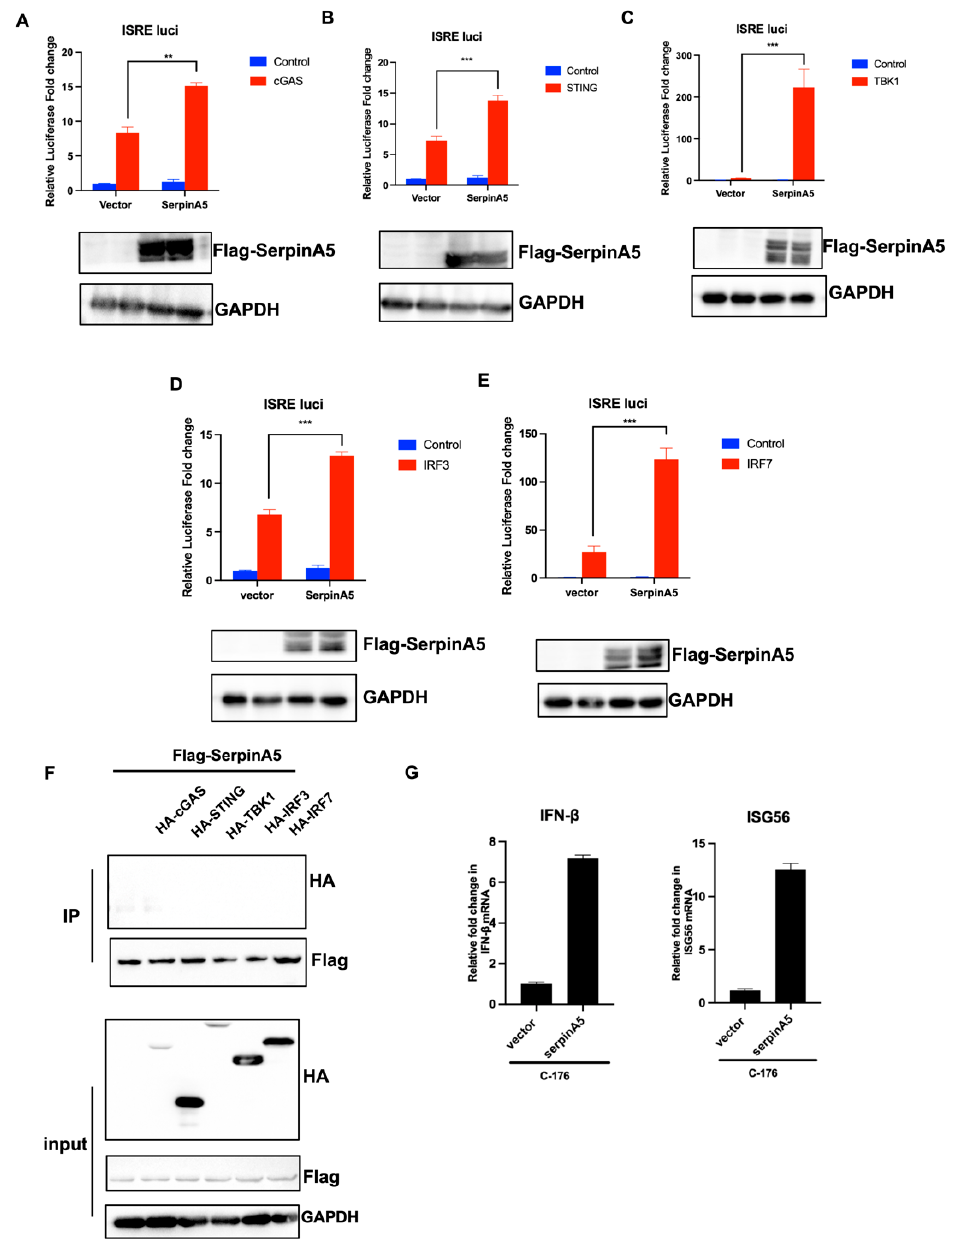
Figure 3. SerpinA5 activated IFN production independent of cGAS-STING signaling pathway. ( A – E ) A549 cells were cotransfected with 8 μ g empty vector or 4 μ g FLAG- SerpinA5-expressing plasmids and HA-tagged cGAS-, STING-, TBK1-, IRF3-, or IRF7-expressing plasmids with ISRE luciferase reporter plasmid and the internal control plasmid pRL-TK. The luciferase activity was determined at 24 h post transfection. Data from at least triplicate experiments were shown as the mean ± SD. ** p < 0.01, *** p < 0.001. ( F ) HEK-293T cells were transfected with 8 μ g vector or FLAG-SerpinA5-expressing plasmids and 4 μ g HA- tagged cGAS-, STING-, TBK1-, IRF3-, or IRF7-expressing plasmids for 36 h. The cells were collected and subjected to immunoprecipitation experiments and immunoblotting analysis. The lysates were immunoprecipitated using anti–HA antibody and subjected to Western blotting analysis using the indicated antibodies. ( G ) Raw264.7 were transfected with vector and serpinA5-expressing plasmids for 12 h, treated with C-176 0.2 μ M for 4 h, and then infected with HSV-1 for 6 h. The cells were collected and the expression levels of IFN β and ISG56 RNA were determined by qPCR.